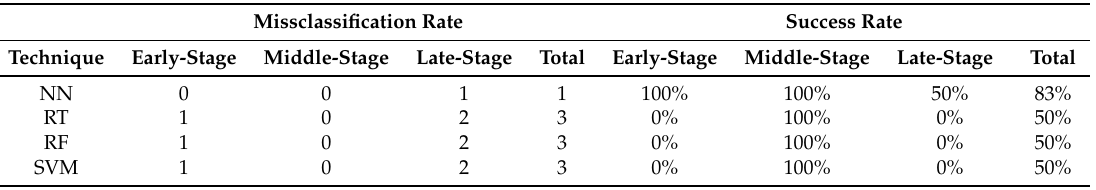
Table 5. Experiments with other methods for supervised classification. NN stands for neural networks, RT for random trees, RF for randon forest, and SVM for support vector